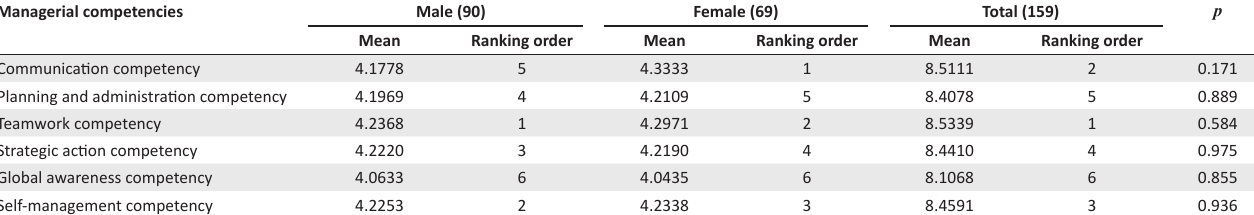
TABLE 11: Comparison of the six managerial competencies by gender using the Mann–Whitney test. Managerial